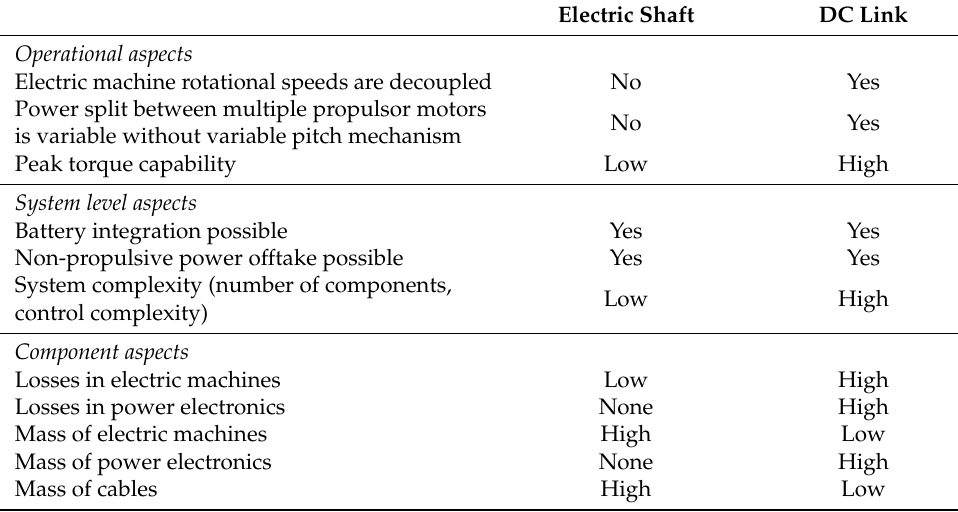
Table 3. Comparison of the electric shaft and the DC link topology.